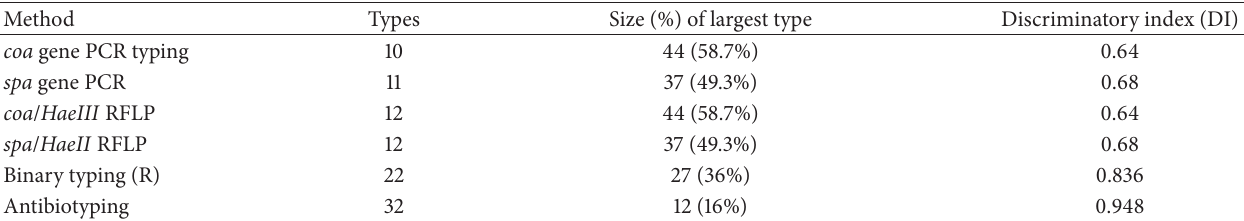
Table4:Discriminatoryindices(DIs)ofthebinarytypingmethod(R)comparedwiththe coa and spa genotypingtechniquesandantibiogram for the 75 MRSA